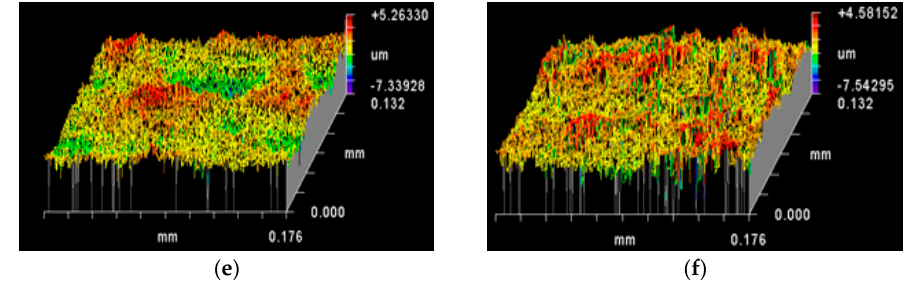
Figure 4. Effect of heat treatment at 130 °C for 1h on the surface topography of the different chemical etched Ag substrates (as mapped by Zygo interferometer): ( a ) native flattened Ag wire; ( b ) 30 s NH 4 OH; ( c ) 10 s HNO 3 ; ( d ) 2 m HNO 3 ; ( e ) 30 s NH 4 OH followed by 10 s HNO 3 ; and ( f ) 30 s NH 4 OH followed by 2 m HNO 3 etching treatments.